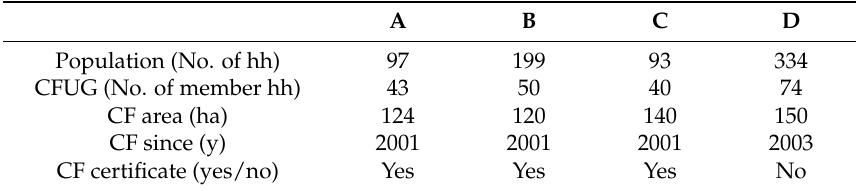
Table 1. Characteristics of the study villages (CFUG = community forestry user group, hh = households).